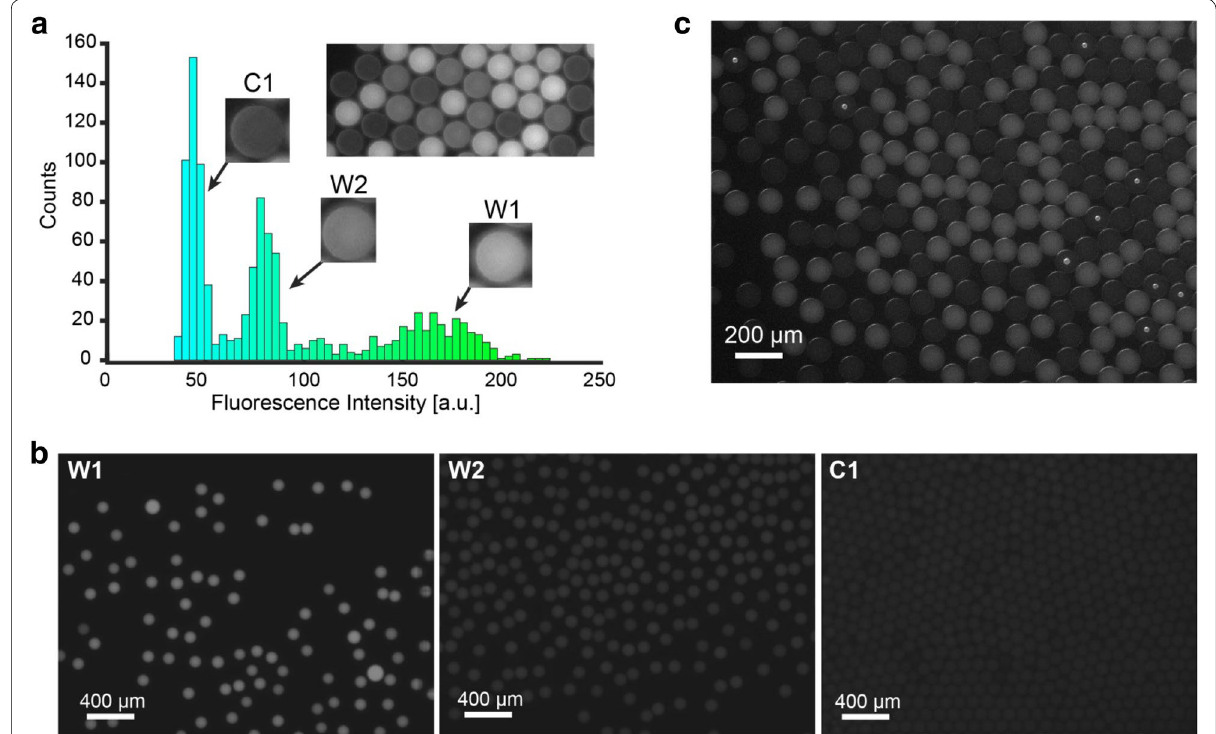
Fig. 5 Fluorescence measurements of droplet concentration after washing. a Droplets from outlets W1, W2, and C1 were pooled from the two-stage device, imaged and fluorescence intensity recorded. b Fluorescence images of droplets collected individually from outlets W1 (left), W2 (center), and C1 (right). c Droplets from outlets W1, W2 and C1 pooled from a two-stage device in an experiment with 22 µm diameter magnetic microparticles in the input droplets. The auto-fluorescent magnetic microparticles are present only in droplets with low solution